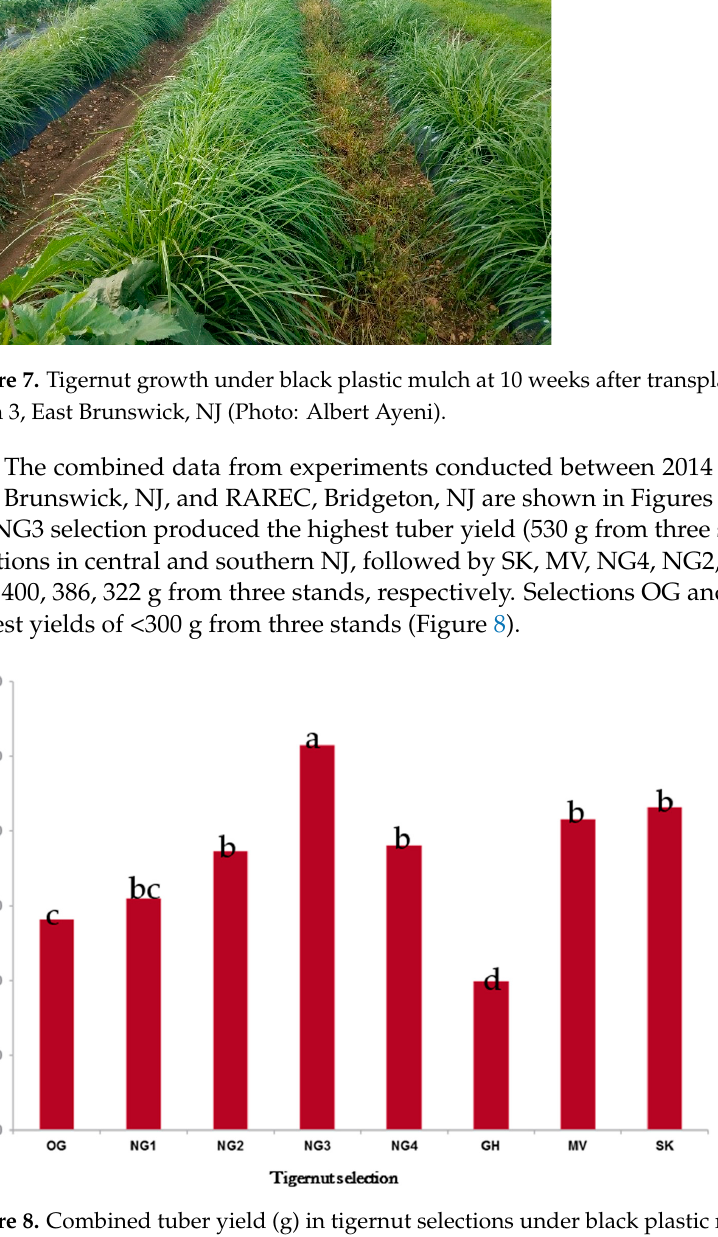
Figure 9. Combined results for tuber yield ratio in tigernut selections grown at Horticulture Farm 3, East Brunswick, Central NJ, and Rutgers Ag Research and Extension Center, Bridgeton, Southern NJ * Tuber yield ratio is the total fresh tuber weight divided by the foliage dry weight. Bars show treatment means separated by Tukey’s HSD test at a 5% significance level. Bars with similar letters are not statistically different. Figure 9 shows the tuber yield ratio (TYR) from the tigernut selections compared in central and southern NJ between 2014 and 2016. The tuber yield ratio (TYR) defined as the tuber weight: shoot dry weight ratio, is a measure of tuber production efficiency.